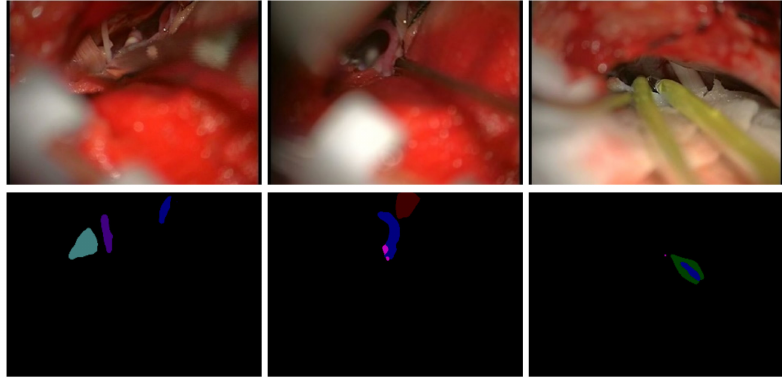
Figure 10. Failure